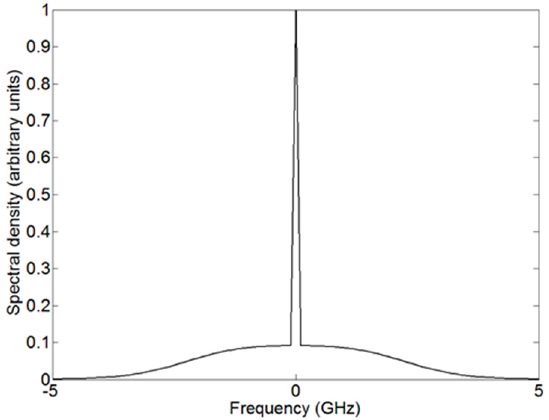
Figure 4. Qualitative backscatter spectrum around the central backscatter frequency of an atmosphere containing aerosol. The frequencies are referred to the one emitted by the laser.